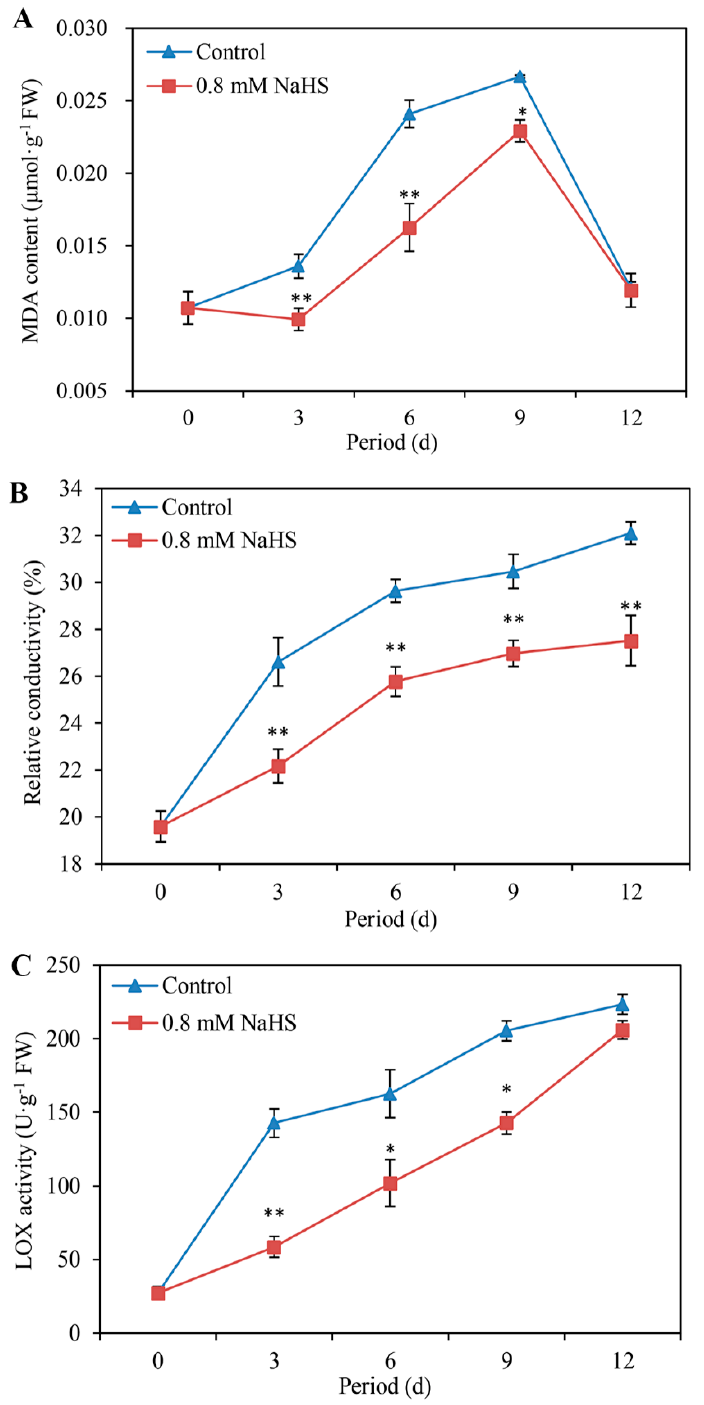
Figure 4. Effects of 0.8 mM NaHS on MDA content ( A ), relative conductivity ( B ), and LOX activity ( C ) of Lanzhou lily scales. The error bars denote the standard errors ( n = 3). The asterisks denote Duncan’s multiple range test for significance: * p <0.05; ** p < 0.01. d: days.